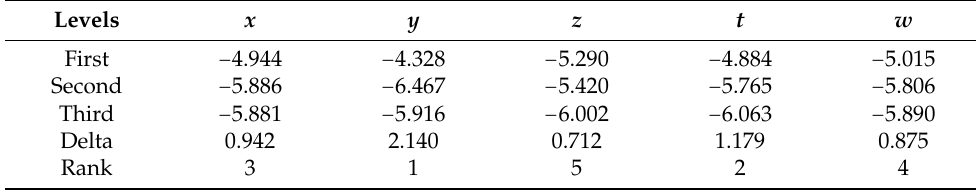
Table 5. Responses for S/N ratio